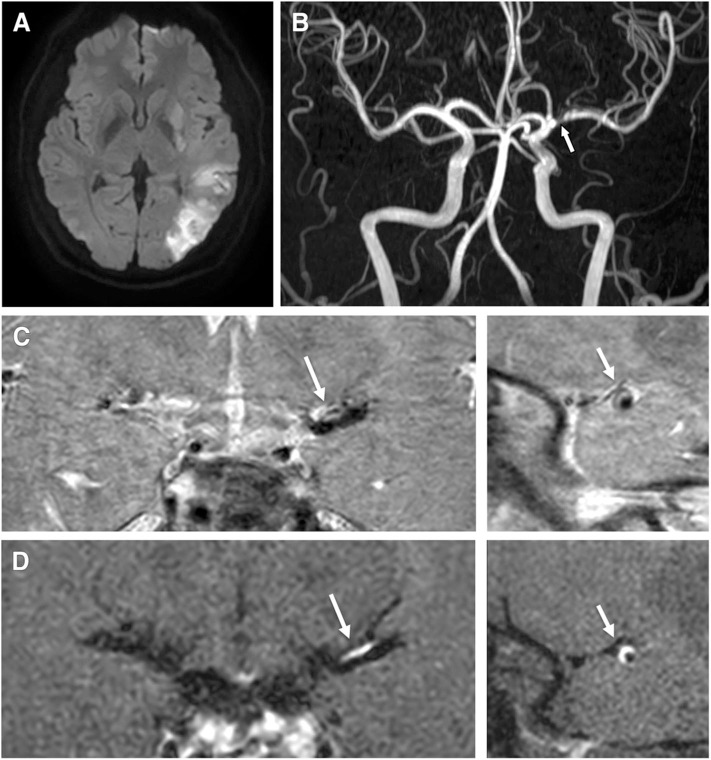
A 40-year-old male patient presented with right hemiparesis and aphasia with low-density cholesterol, total cholesterol, and Apo (b) levels of 178 mmol/L, 225 mmol/L, and 137 g/L, respectively. (A) Axial DWI shows a high signal intensity lesion in the left parietal region. (B) TOF-MRA shows severe stenosis in the left middle cerebral artery (proximal M1, arrow). (C) Pre-contrast 3-dimensional proton-density black-blood magnetic resonance images. (D) Post-contrast images (left: coronal plane, right: sagittal plane) show eccentric wall thickening (arrow) with enhancement.